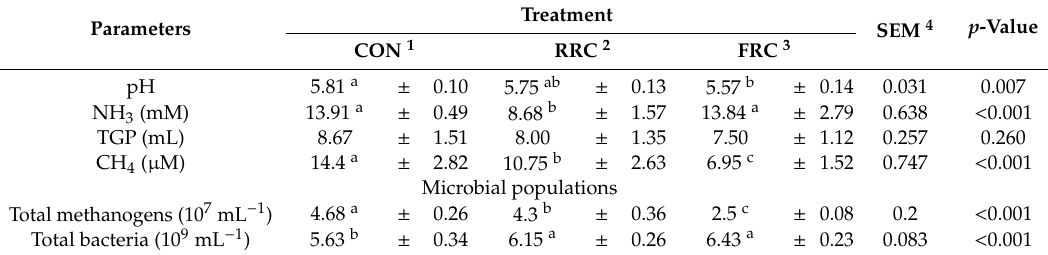
Table 7. E ff ect of diets containing raw rapeseed cake (RRC) and fermented rapeseed cake (FRC) on fermentation parameters (mean ± SD) in the ceca of broiler chickens (28-day-old birds); experiment 3. Parameters